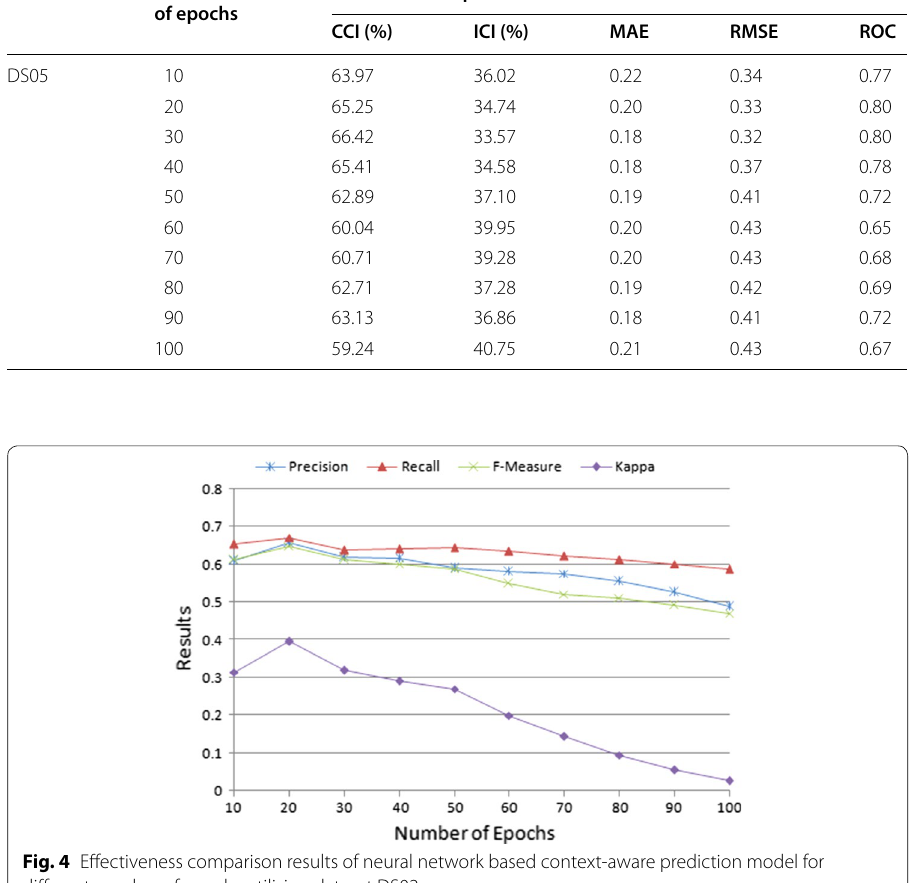
Table 5 Prediction results using neural network learning based context‑aware classification model utilizing dataset DS05